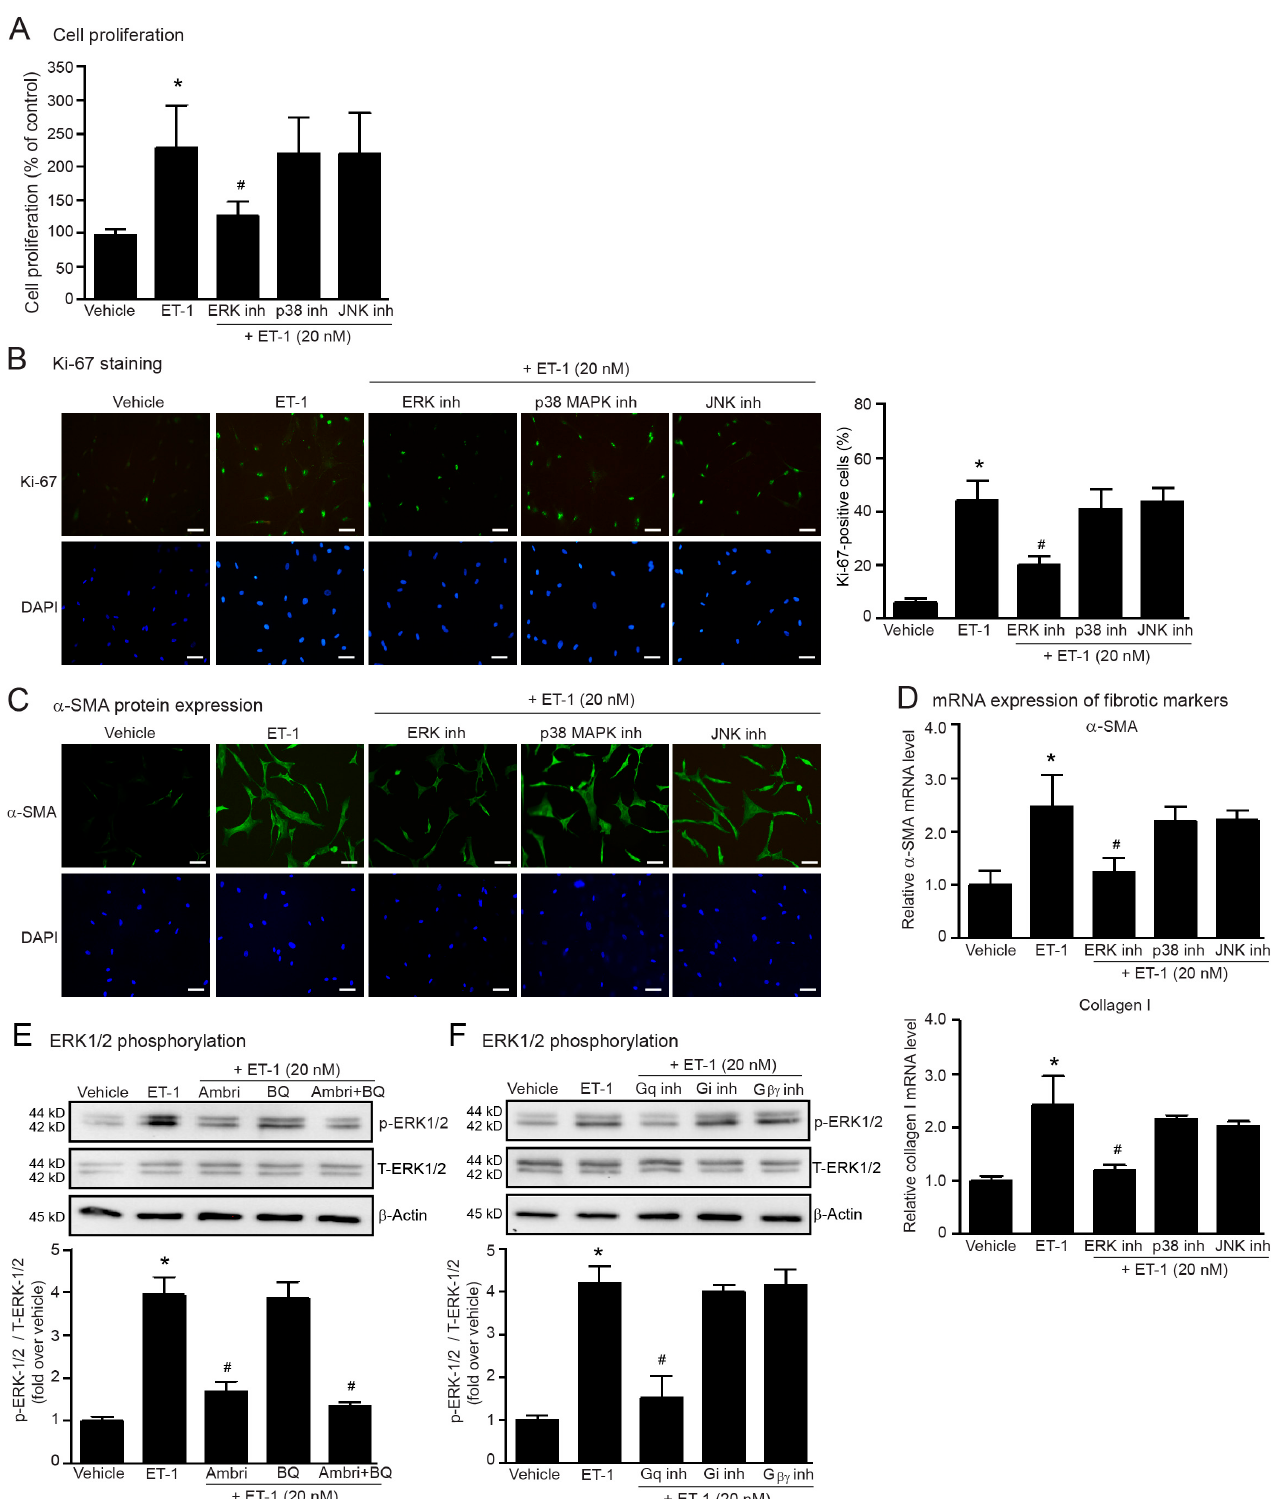
Figure 4. Inhibition of ERK1/2 suppresses ET-1-induced cell proliferation and myofibroblast differ- entiation. Cells were pretreated without or with 1 µM FR180204 (ERK1/2 inhibitor; ERK inh), 1 µM SB203580 (p38 inhibitor; p38 inh), 1 µM SP600125 (JNK inhibitor; JNK inh) for 1 h before treatment with 20 nM ET-1 for 24 h ( A – C ) or 12 h ( D ). ( A ) Cell proliferation was calculated as the percentage relative to the control group. ( B ) Cells were stained for Ki-67 (green) and nucleus DAPI (blue). Scale bar, 10 µm. Proliferative capacity was calculated as the percentage of Ki-67-positive cells. ( C ) α - SMA protein expression was visualized by fluorescent microscope. Cells were stained for α -SMA